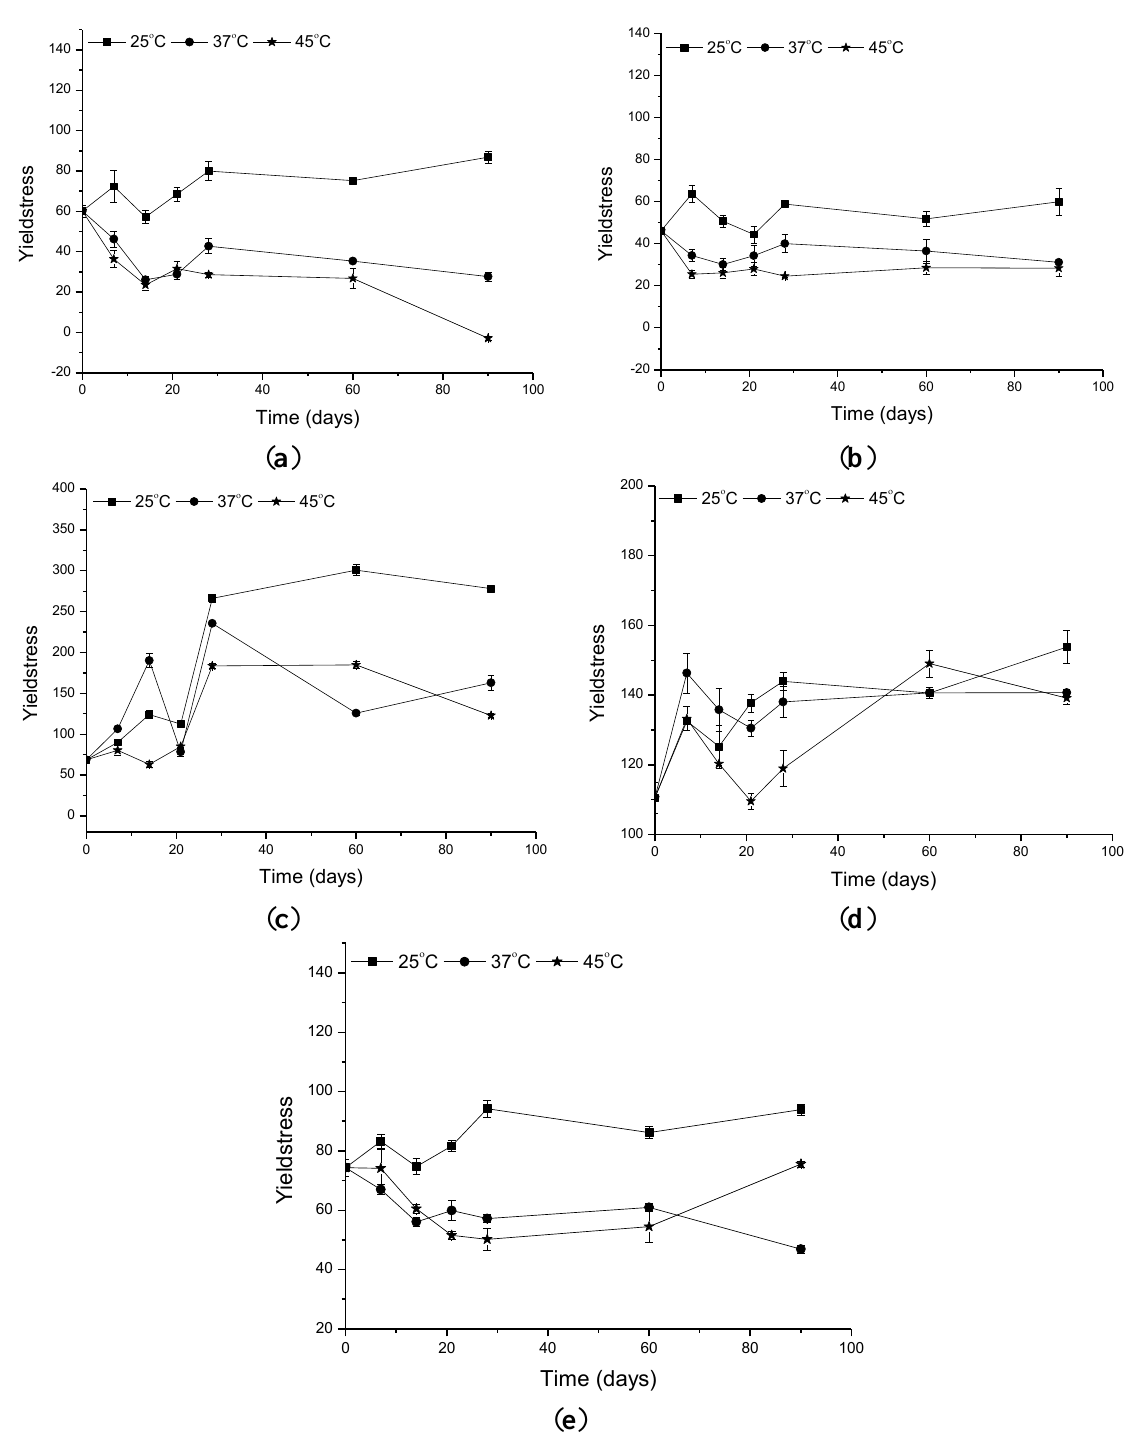
Figure 7. Changes in the yield stress of the ( a ) formulation vehicle ( b ), formulation containing the organic UV filters ( c ) formulation supplemented with CePO supplemented with TiO ( e ) formulation supplemented with ZnO in 0, 7, 14, 21 and 2 28 days after preparation, at 25 °C, 37 °C and 45